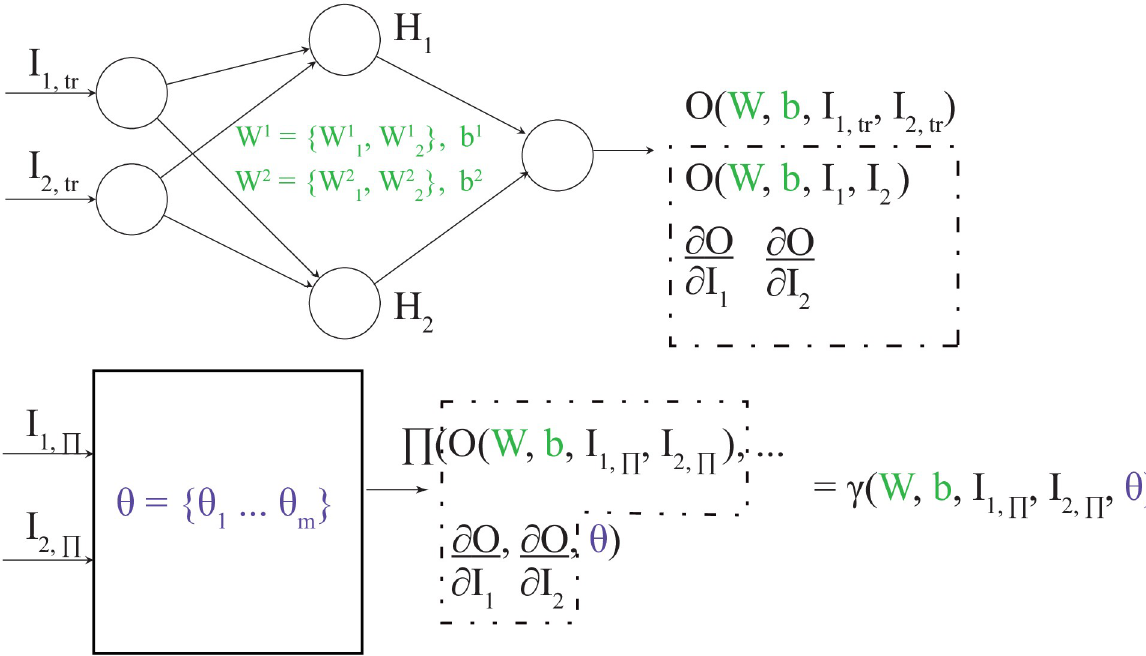
Fig 3. Graphical illustration of how a traditional neural network is linked to a physics-informed neural network. The set of θ represents unknown physical parameters that we want to estimate.